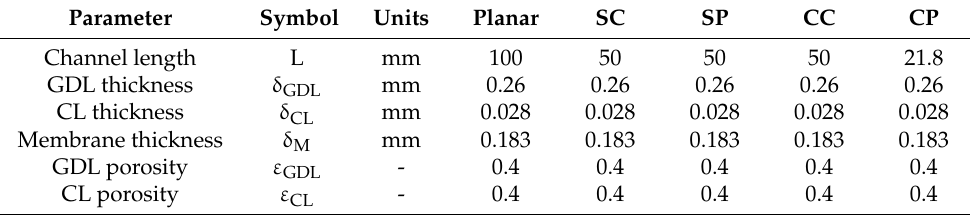
Figure 2. ( a – h ) Computational region. Table 1. Geometrical parameters.